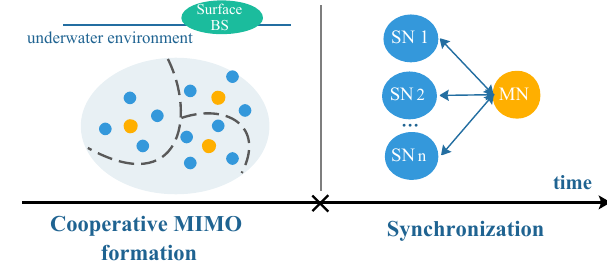
Figure 2. The process diagram of the Set-up